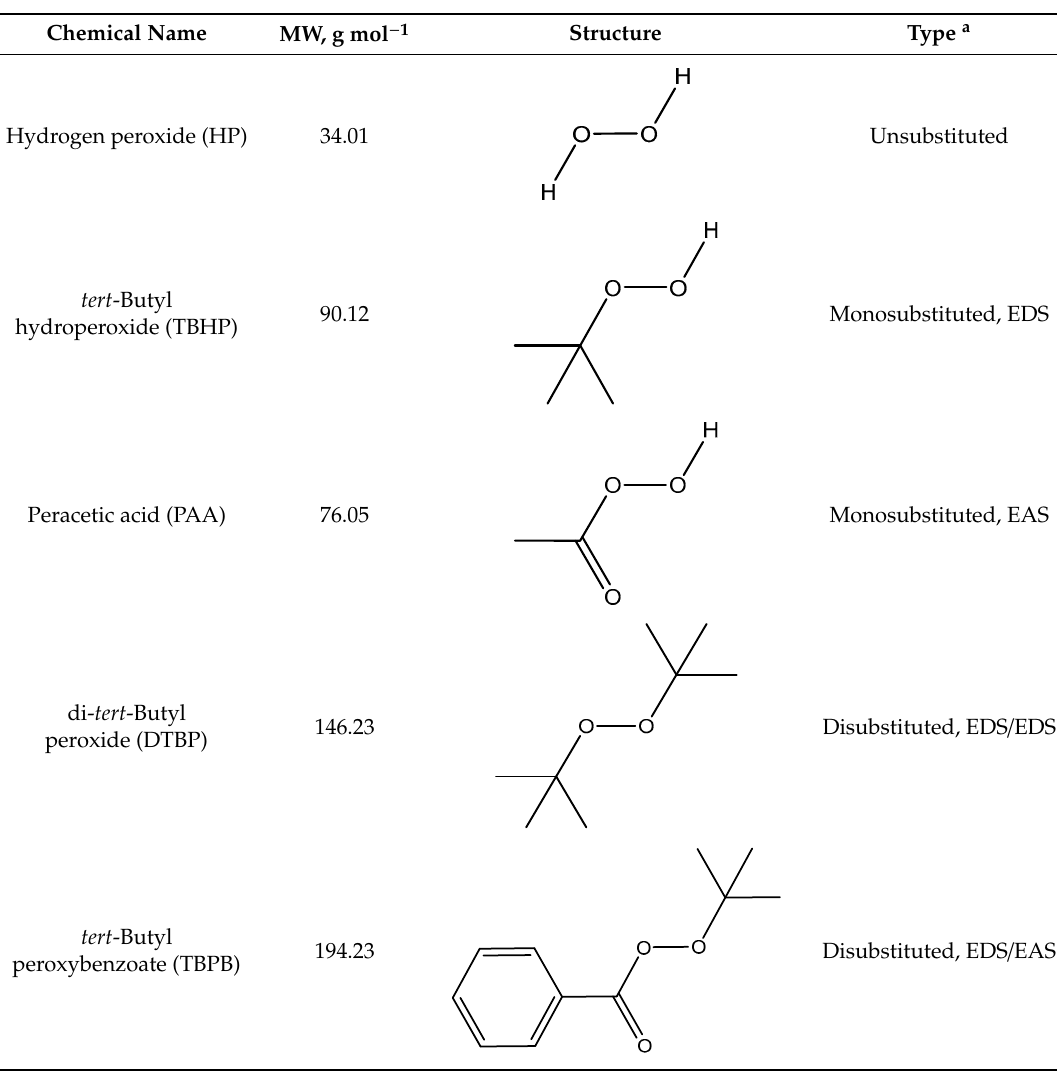
Table 1. Peroxides studied in this work.